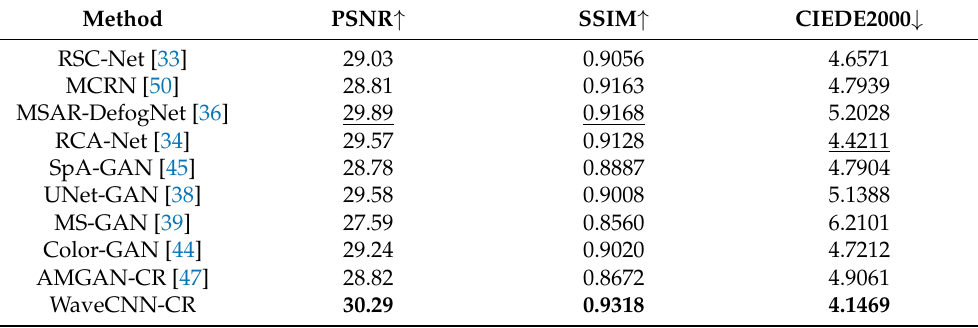
Table 8. Quantitative evaluations on the WHUS2-CR dataset. The bold and underlined text indicates the best and second-best performance, respectively. The ↑ symbol indicates that larger values are better, while ↓ indicates that smaller values are better.